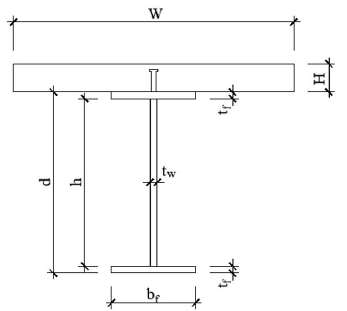
Figure 2. Nomenclatures of the dimensions of composite beam cross-section.